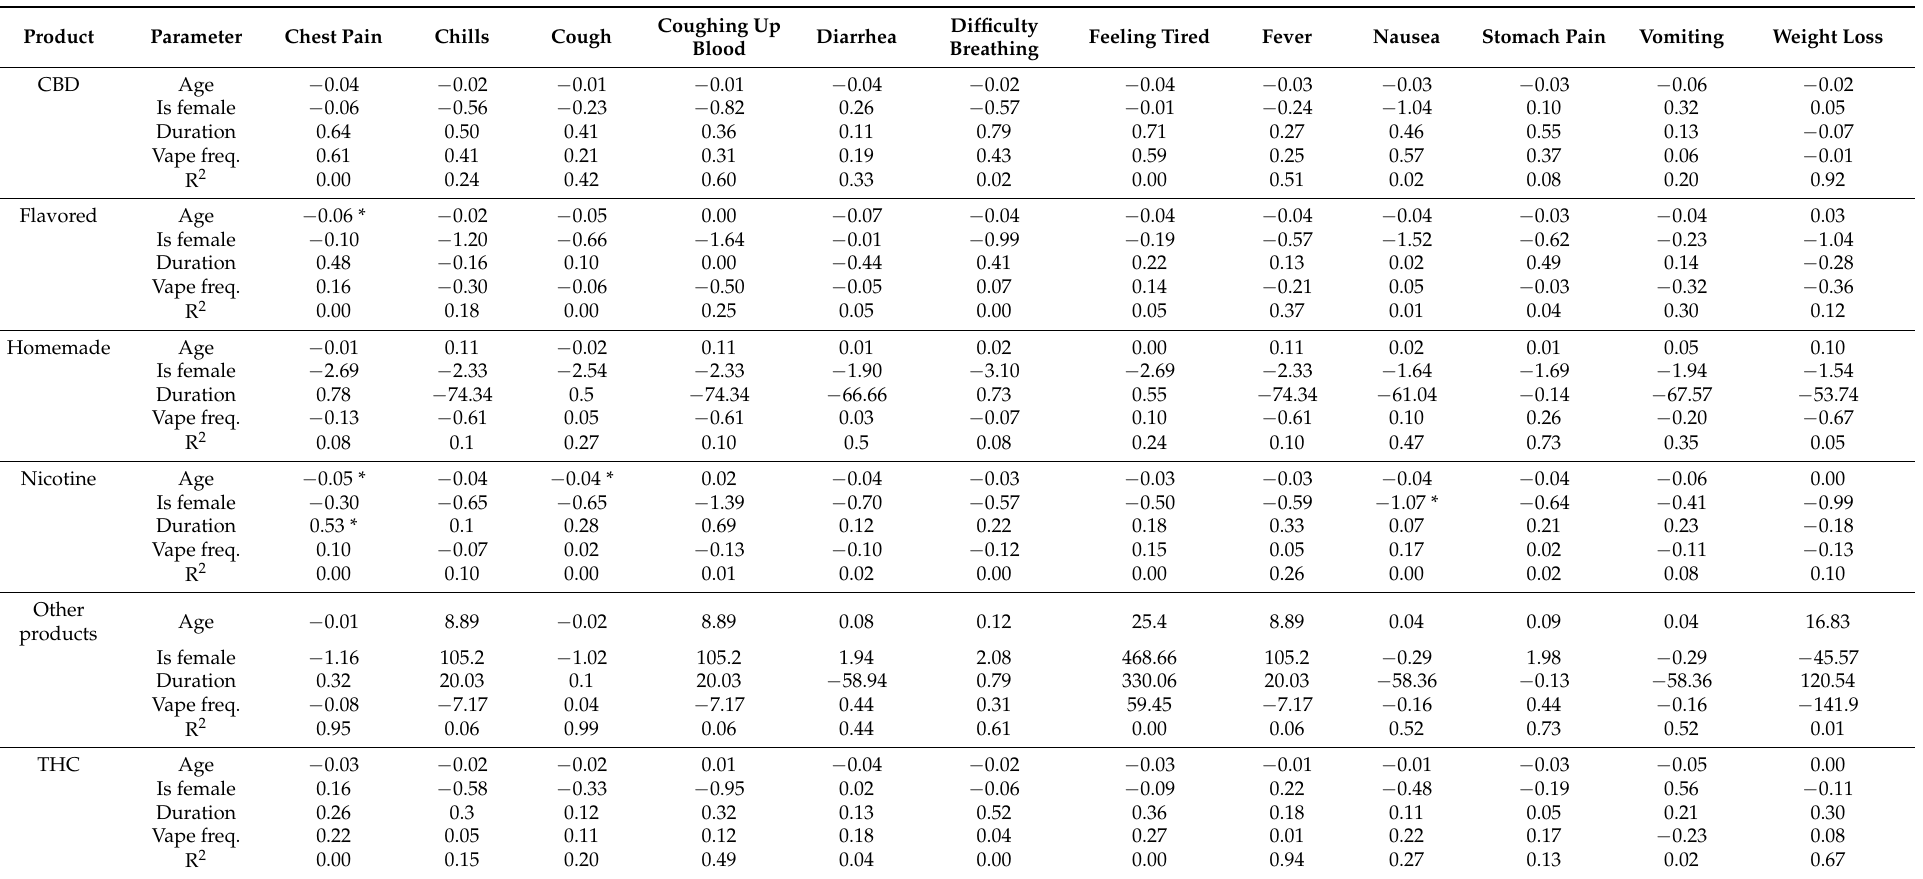
Table A1. Logistic regression model coefficients for separate ingredients. Stars denote statistically significant results ( p < 0.05, with Bonferroni correction for 6 ingredients and 12 adverse reactions). Duration refers to the reported duration of